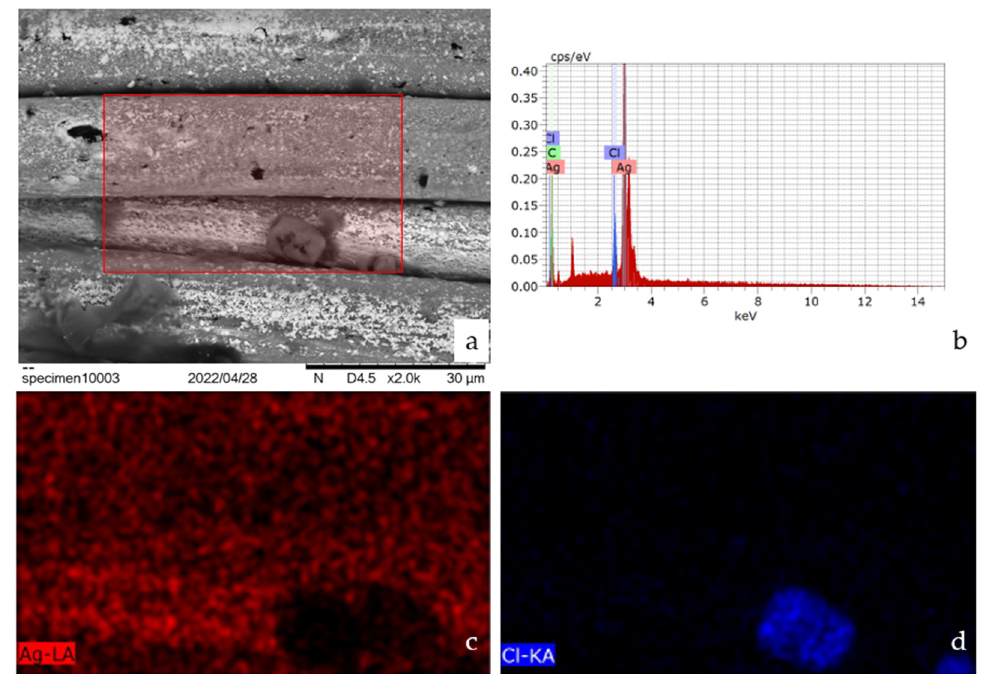
Figure 10. SEM image of the washed thread with the EDX margins highlighted ( a ), EDX spectra ( b ), silver ( c ), and chlorine ( d ) mapping at a ×2000 magnification.